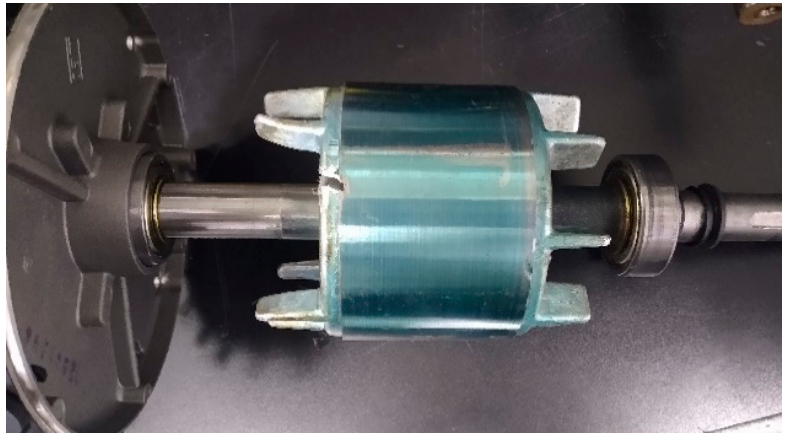
Figure 6. RCIM cracked ring rotor and broken rotor bar for analysis.